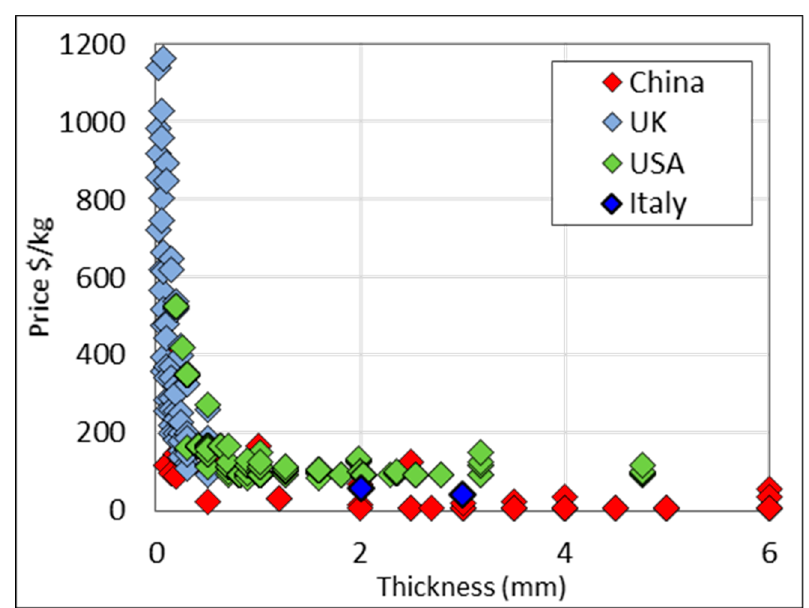
Figure 13. Price data for grades 1–4 titanium strip. Country of origin distinguished by color.